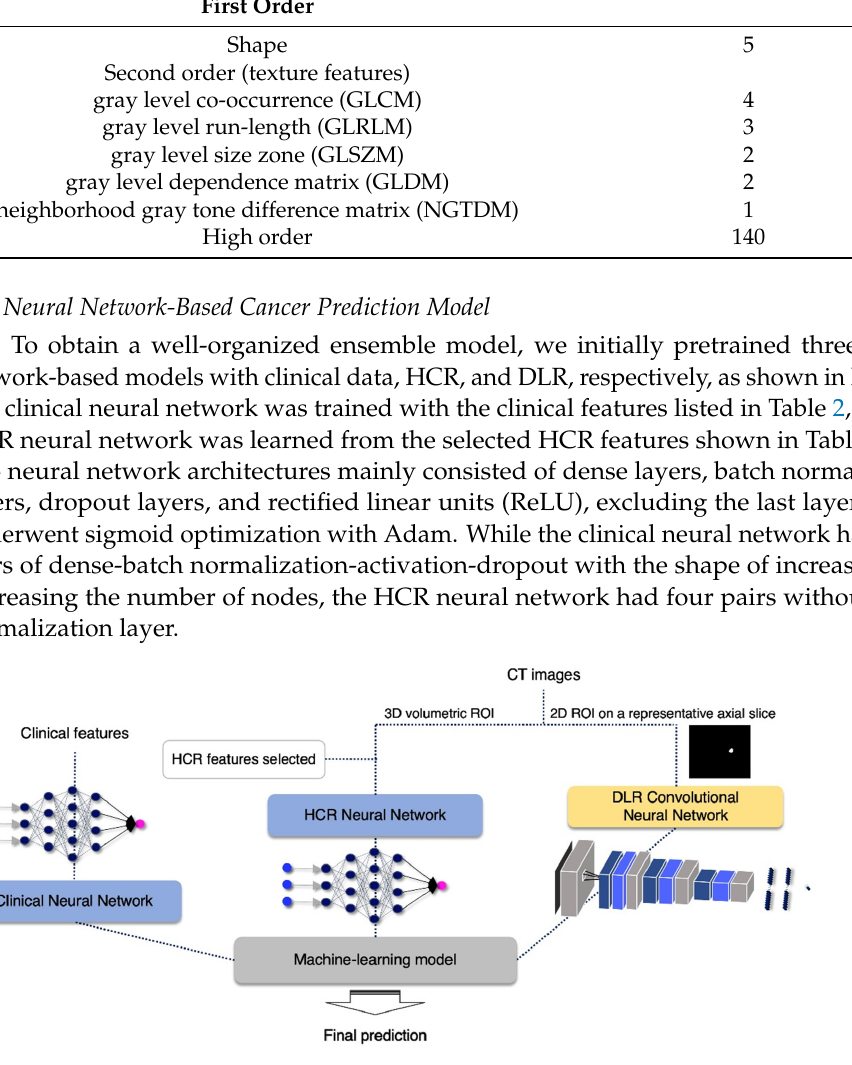
Figure 2. Flow chart of the proposed algorithm .